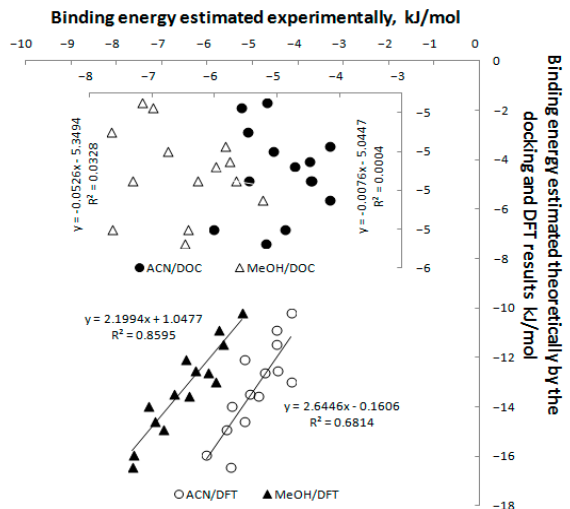
Figure 8. The comparison of the Gibbs free energy change ( ∆ G ◦ ) estimated experimentally on Chirobiotic column with methanol (MeOH)- or acetonitrile (ACN)-containing eluent system and obtained by the use of docking simulation (insert) and DFT calculations.